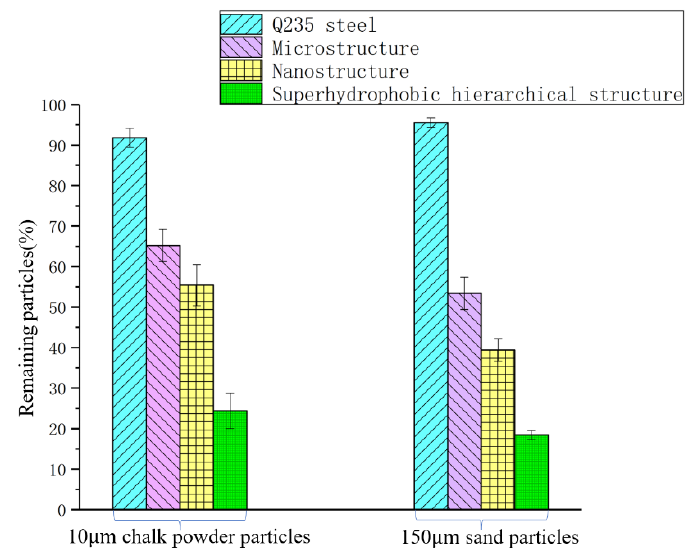
Figure 14. Bar chart of self-cleaning efficiency of surfaces with different wettabilities.